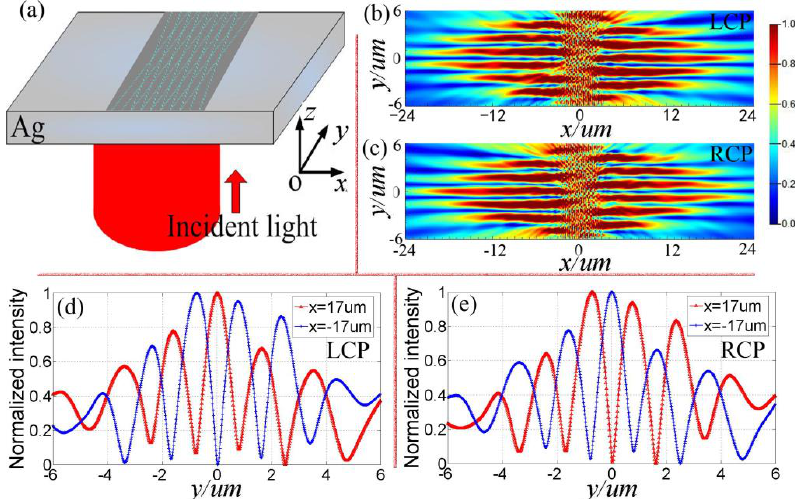
Figure 2. Numerical verifications on the feasibility of simultaneously generating plasmonic zero-order and first-order Bessel-like beams by using a single device. ( a ) Schematic diagram of the optical configuration for X-shaped plasmonic devices. FDTD simulated SPP field intensity for the X-shaped device illuminated by ( b ) LCP light and ( c ) RCP light. As a comparison, the normalized intensity values along y-axis at x = ±17 μm in ( b ) and ( c ) are extracted and plotted in ( d ) and ( e ), respectively. ( d ) for LCP light and ( e ) for RCP light.